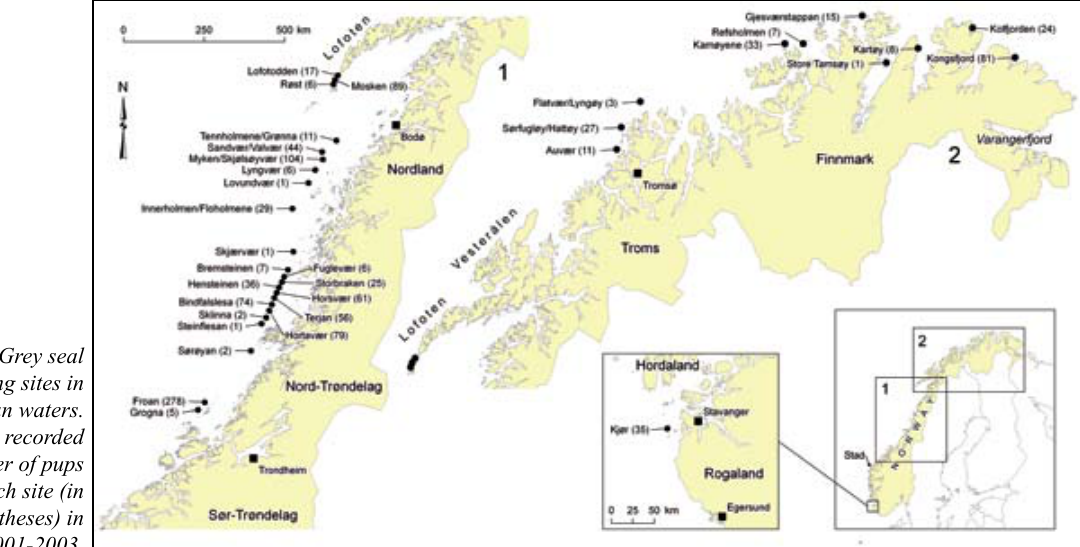
Fig. 1. Grey seal breeding sites in Norwegian